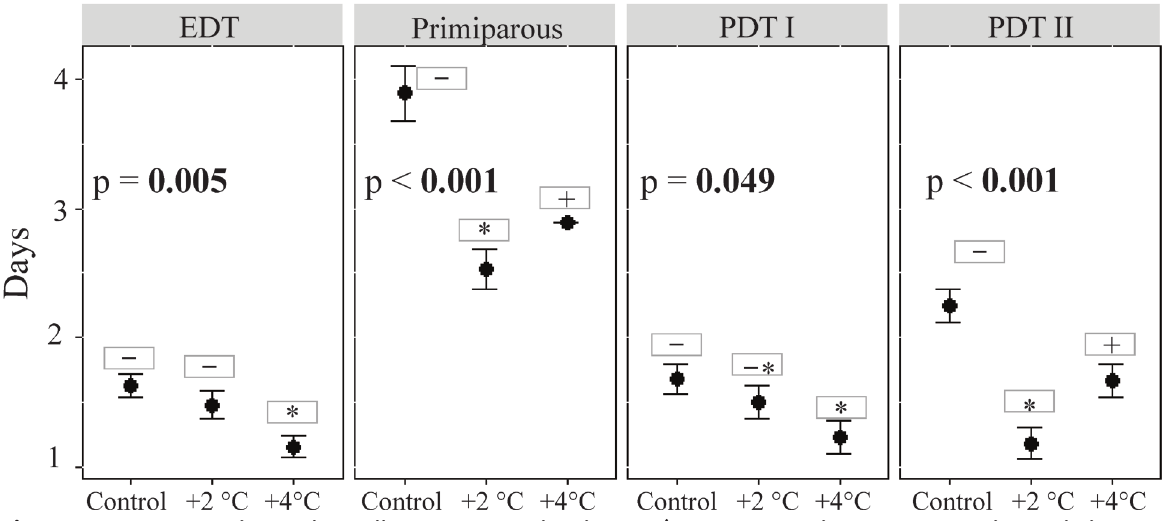
Figure 4. Box plot showing C. silvestrii development time in days (EDT = embryonic development time; Primiparous = from neonate to the first clutch; PDT I = neonate to juvenile; PDT II = juvenile to adult) at three temperatures (control, +2 and +4°C), p-value from Kruskal-Wallis analyses is shown. Symbols (-,*,+) above the columns indicate significant differences in post-hoc analyses - treatments that share a symbol do not differ significantly, p >0.05. • indicates the mean, ± standard error bars are